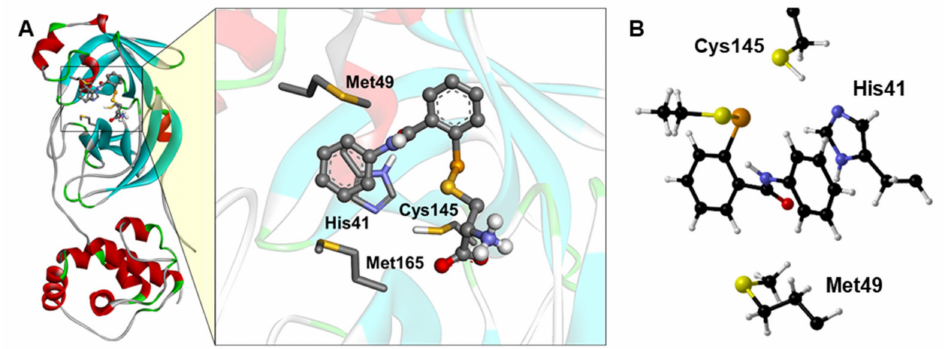
Figure 3. ( A ) Docking simulations between M pro and EbSeS. The carboxyl and amino moieties of EbSe-Cys were replaced with H atoms to create the ethanthiolate (EbSeS), as a general model of EbSe-thiol adduct/metabolite. For better visualization, only the side chain of the main residues is shown. ( B ) Optimized M pro cluster, with EbSeS docked inside. For clarity, only C α , H α and amino acid side chains are displayed, Met165 is not shown and the cluster is oriented for optimal view.